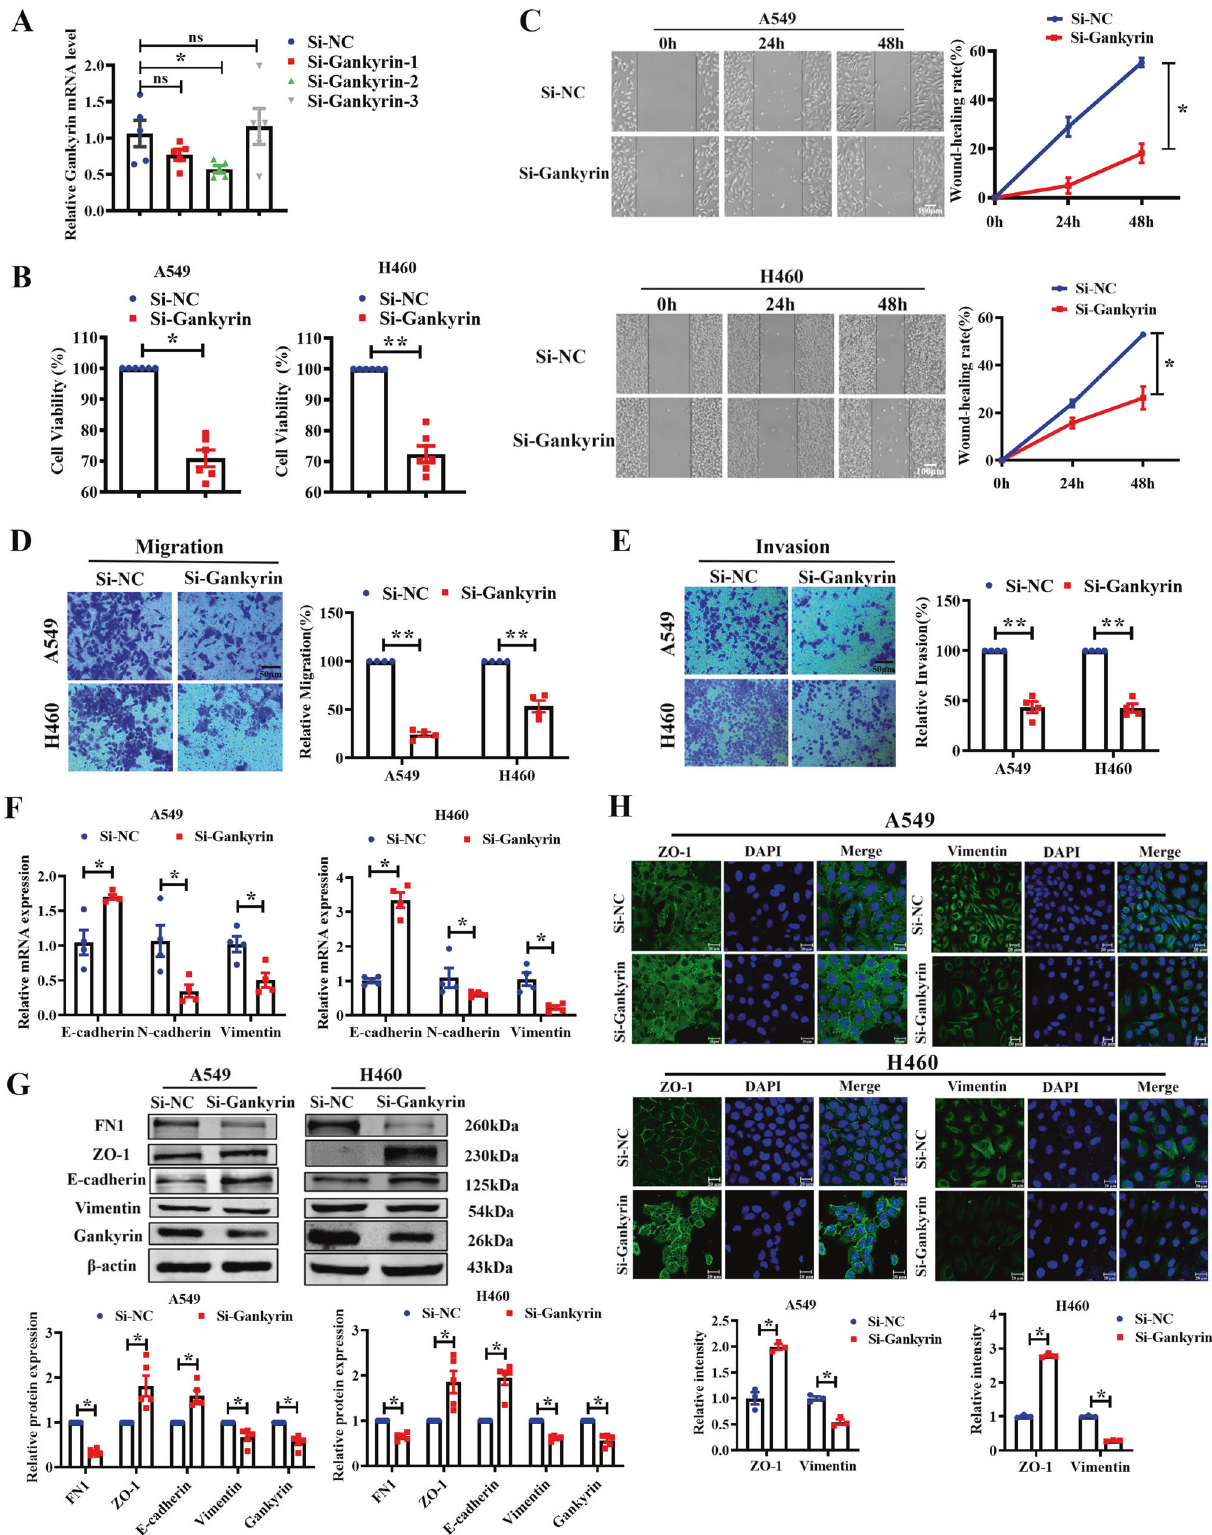
Fig. 3 Gankyrin knockdown inhibits malignant phenotypes of NSCLC cells in vitro. A Real-time PCR analysis veri fi ed the ef fi ciency of Gankyrin knockdown ( n = 5, * P < 0.05, ns means no signi fi cant). B Viability of A549 and H460 cells as determined using MTT assay ( n = 6, * P < 0.05, ** P < 0.01). C Wound-healing assays showing cell migration in A549 and H460 cells ( n = 5, * P < 0.05, Scale bars: 100 μ m). D Migration assays in A549 and H460 cells, respectively ( n = 4, ** P < 0.01, Scale bars: 50 μ m). E The invasion of A549 and H460 cells was determined via invasion assay using Matrigel transwell chambers ( n = 4, ** P < 0.01, Scale bars: 50 μ m). F mRNA levels of EMT-relevant markers in A549 and H460 cells ( n = 4, * P < 0.05). G Levels of the EMT-relevant markers E-cadherin, FN1, ZO-1, and Vimentin in A549 and H460 cells ( n = 5, * P < 0.05). H Immuno fl uorescence assay was used to detect the Vimentin and ZO-1 levels in A549 and H460 cells (Scale bars: 20 μ m). Vimentin and ZO-1 intensity assays were shown at the bottom of the image ( n = 3, * P <